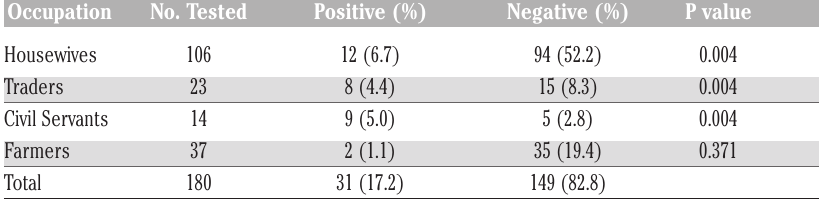
Table 3. Distribution of Hepatitis B virus based on demographic